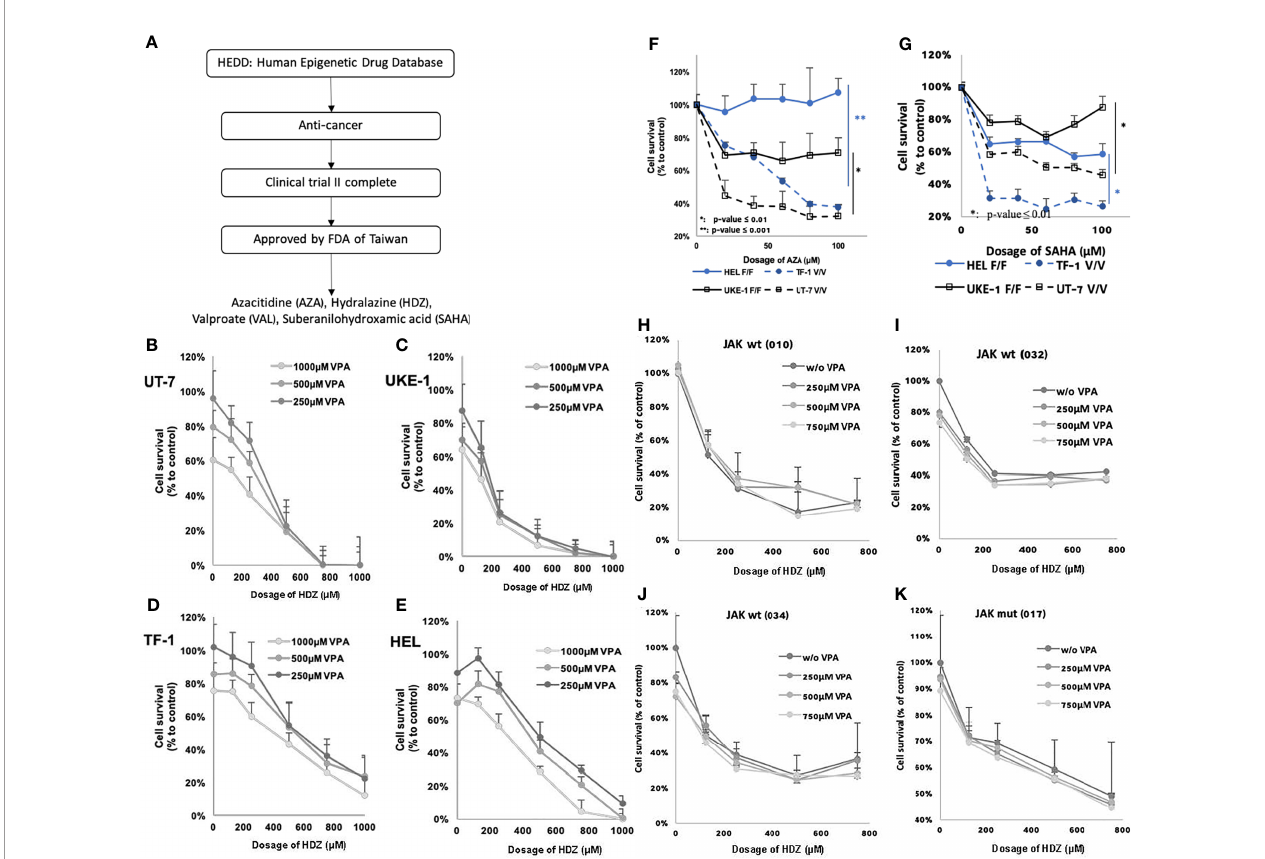
FIGURE 1 | Flowchart showing steps for screening candidate drugs, from in silico and in vitro to ex vivo . (A) In-silico screening led to four candidate drugs AZA, HDZ, VAL, and SAHA. (B – E) JAK2V617F mutation may affect the therapeutic ef fi cacy of AZA and SAHA, but not of HDZ-VAL. The cell survival of four MPN cell lines treated with HDZ-VAL combination. (F, G) The cell survival rate of four MPN cell lines treated with AZA or SAHA. (H – K) The inhibitory ef fi cacy of cell survival rate after HDZ-VAL combinational treatment on the leukocytes of PV or ET